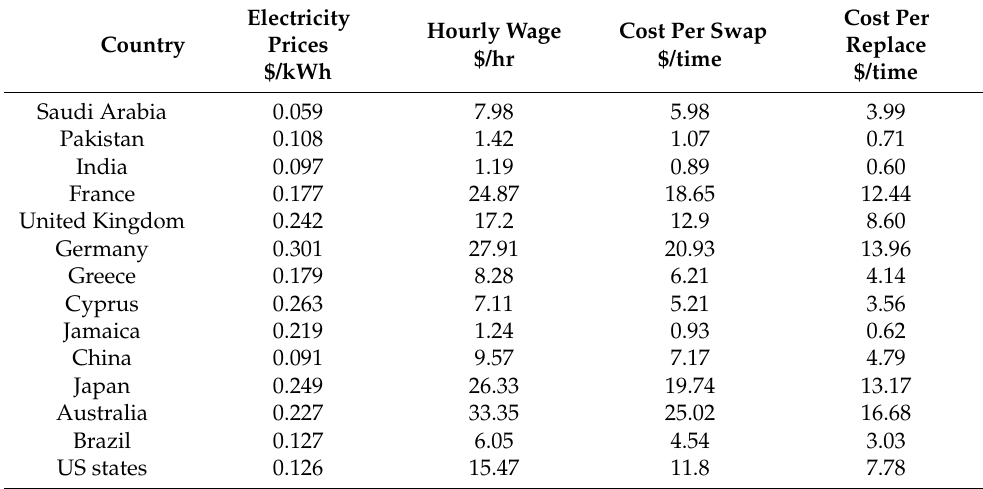
Table 4. Electricity price and labor cost in